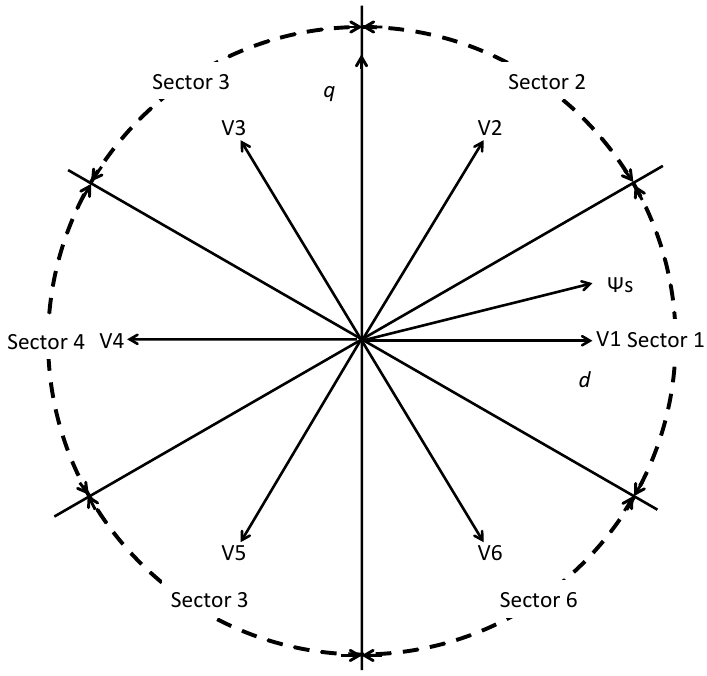
Figure 4. Voltage vectors and sectors definition.